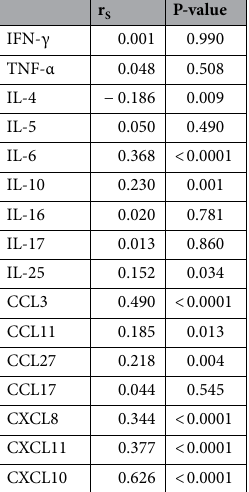
Table 3. Correlation of biomarkers with CXCL9 levels in patients with asthma. Significant correlations are indicated. The correlation coefficients were generated by Spearman’s correlation analysis. Results were considered significant at P < 0.05. TNF tumour necrosis